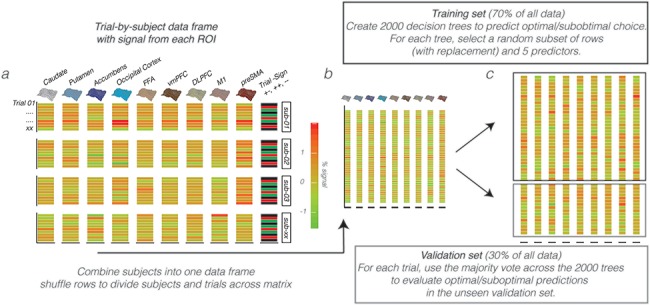
Random Forest input and data-structure. (a) Trial-by-subject data matrix with the \documentclass[12pt]{minimal}
\usepackage{amsmath}
\usepackage{wasysym} 
\usepackage{amsfonts} 
\usepackage{amssymb} 
\usepackage{amsbsy}
\usepackage{upgreek}
\usepackage{mathrsfs}
\setlength{\oddsidemargin}{-69pt}
\begin{document}
}{}$\%$\end{document} signal change drawn for each choice trial in the transfer phase (rows) from \documentclass[12pt]{minimal}
\usepackage{amsmath}
\usepackage{wasysym} 
\usepackage{amsfonts} 
\usepackage{amssymb} 
\usepackage{amsbsy}
\usepackage{upgreek}
\usepackage{mathrsfs}
\setlength{\oddsidemargin}{-69pt}
\begin{document}
}{}$9$\end{document} apriori defined ROI (columns). In addition to the ROI data, the matrix contained a column with the identity of participants (sub-01, etc.) and Trial Sign, which specified a choice between two positives (+/+; AC, AE, CE), negatives (−/−, BD, BF, DF), or between a negative and positive option (+/−, e.g., AD, CF, etc.) given the feedback scheme in the learning phase. (b) The individual subject data frames were then combined into one matrix, in which the rows were subsequently shuffled to randomly distribute trials and subjects across the rows. (c) This matrix was then divided into a training set (two-thirds of the data) for the creation of 2000 decision trees of which the majority vote on each trial is then used to evaluate the predictive accuracy of optimal/suboptimal choices in a separate validation set (one-third of the data).